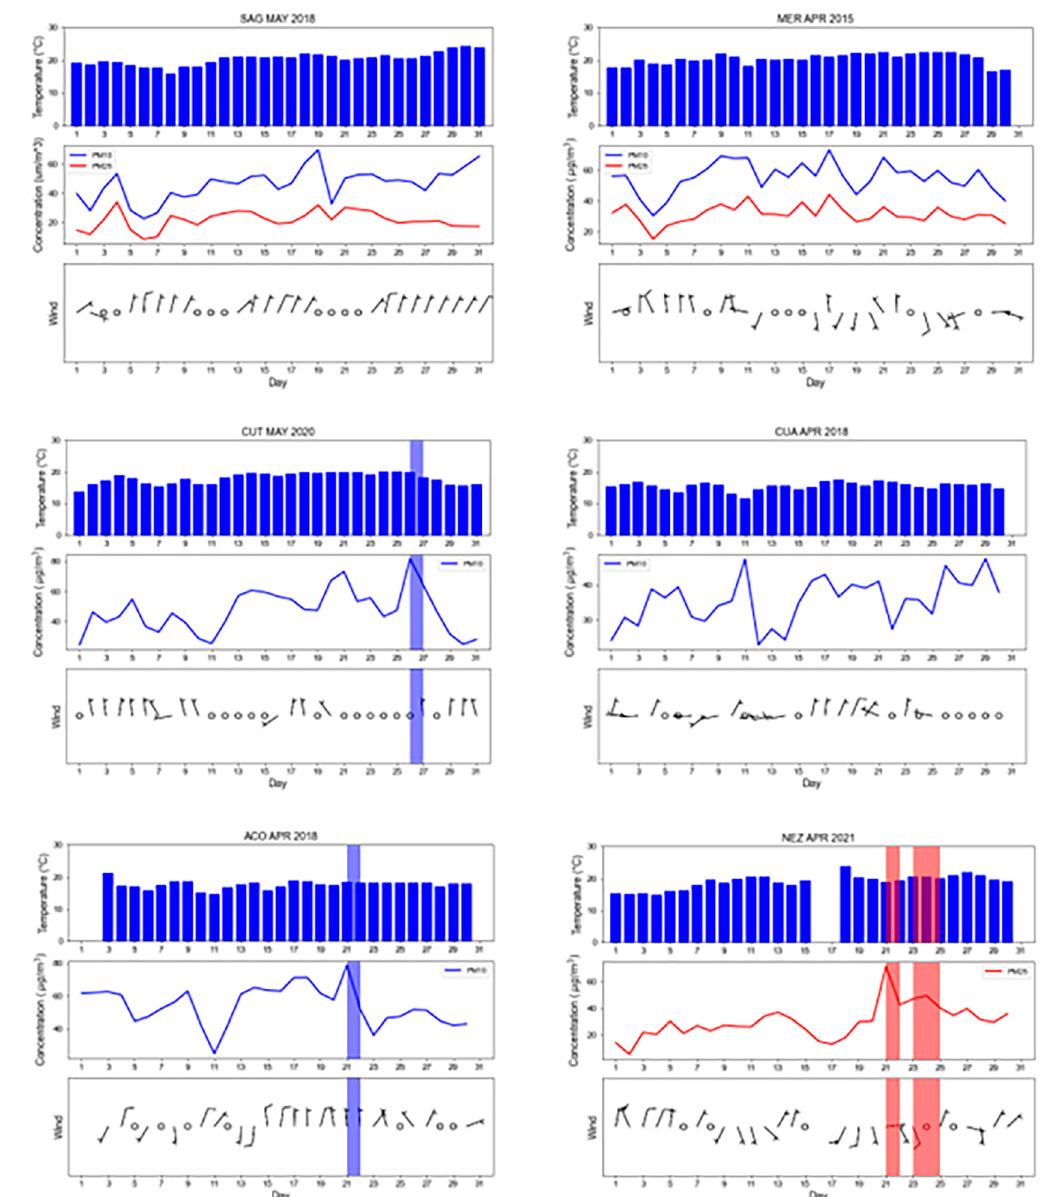
Figure A5. Meteograms for stations in Mexico City with a significant relation between wind speed and PM concentrations. Blue bars represent days over the PM 10 maximum established by the national standard for air quality. The yellow bars indicate exceeding both PM 10 and PM 2.5 maxima, and the red bars show days over the limit for PM 2.5 .